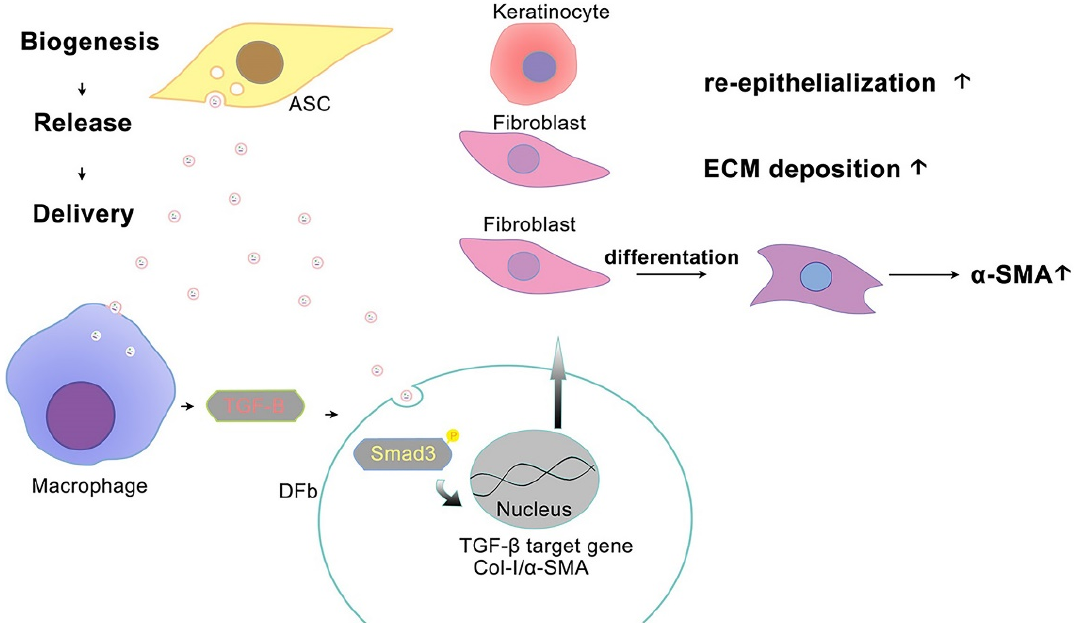
Figure 7. A proposed mechanism depicting the pathway by which diabetic ASC-Exo enhances diabetic wound healing. By adding ASC-Exo, resident monocytes/macrophages were stimulated to secrete more TGF- β 1 and activate the TGF- β /Smad3 signaling pathway. Of note, ASC-Exo could increase the production of TGF- β 1 of fibroblasts. Collectively, these findings indicate that TGF- β 1 is centrally involved in ASC-Exo mediated cellular crosstalk as an important early response to initiate wound regeneration.